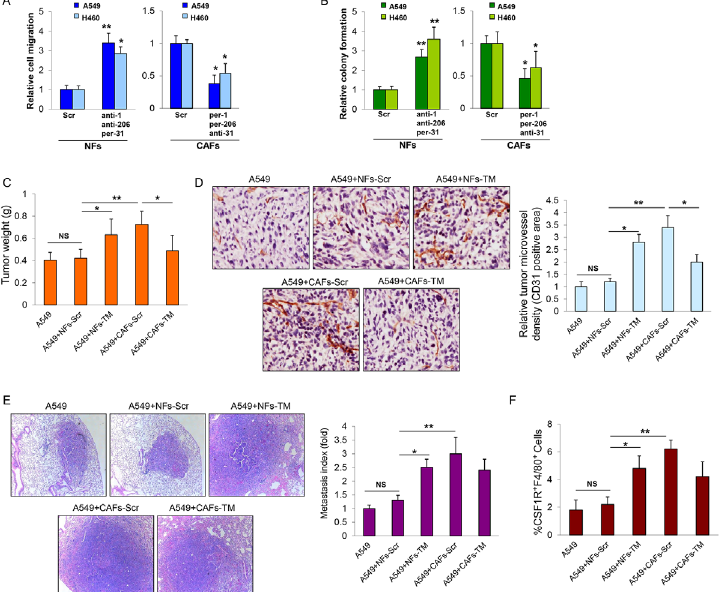
Fig 2. Function roles of miR-1, miR-206 and miR-31 in NFs and CAFs. (A, B) NFs were triple transfected with anti-miR-1, anti-miR-206 and pre-miR-31 (NFs-TM) or CAFs were triple transfected with pre-miR-1, pre- miR-206 and anti-miR-31 (CAFs-TM). Cell migration assay was performed to assess LCCs migration efficiency in response to CM from co-cultured cells (A). Colony formation assay was performed to determine LCCs colony formation ability when co-cultured with NFs-Scr, NFs-TM, CAFs-TM, or CAFs-Scr (B). Cells transfected with miR-Scr were used as control. (C-F) A549cells were subcutaneously injected alone or co- injected with NFs-Scr, NFs-TM, CAFs-TM, or CAFs-Scr into immunodeficient mice. Xenografts were removed 6 weeks after implantation. Tumor weights were obtained and presented (C). Representative CD31-stained section of tumors. The blood vessels in tumor were stained using CD31 antibody and positive- stained blood vessels were counted in five areas with maximum number of microvessels under the microscope for each slide with 5 slides per experiment. The results are normalized to A549 group and presented as Mean ± SEM; (n = 8) (D). Representative haematoxylin-and eosin (HE)-stained section of lungs of mice bearing the indicated tumors. Lung sections were scanned and were scored for metastatic foci. Metastasis index (= metastasis number divided by primary tumor weight) (mean ± SEM; n = 8) (E). The percentage of CSF-1R+F4/80+ in tumors was determined by flow cytometry assay (F) (mean ± SEM; n = 8). * p < 0.05, ** p < 0.001, NS indicated nonstatistical